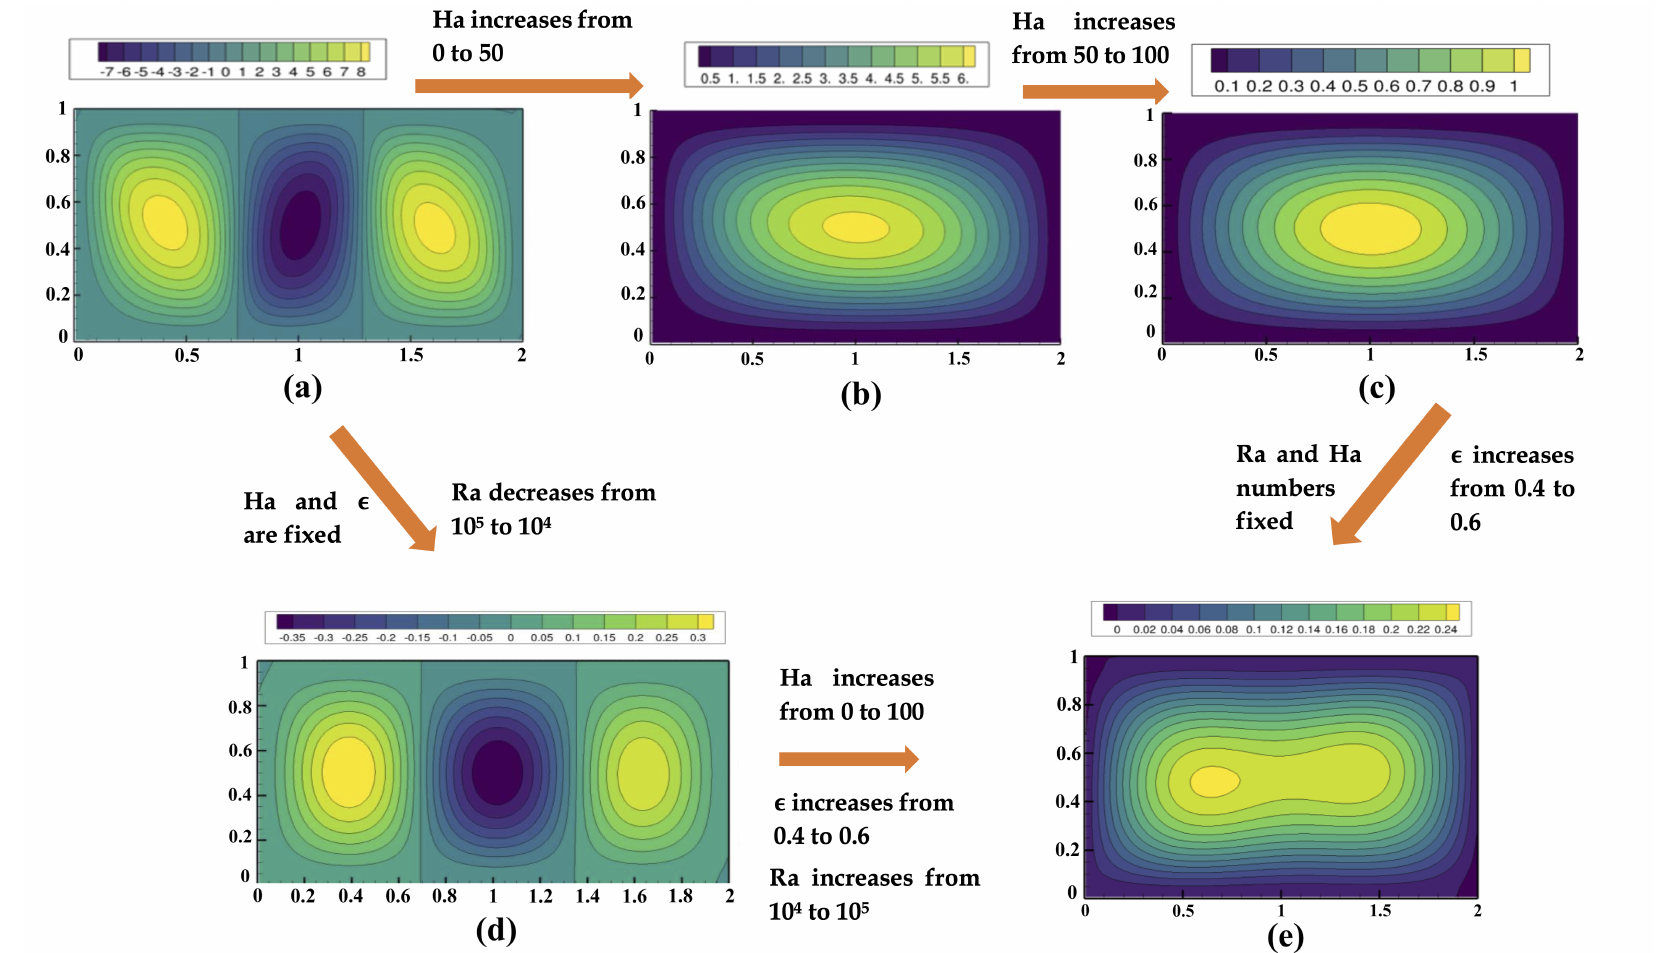
Figure 3. Illustrations of streamlines as Ra , Ha numbers, and (cid:101) varied under θ = 0, and Da = 10 − 2 : ( a ) Ra = 10 5 , (cid:101) = 0.4, and Ha = 0, ( b ) Ra = 10 5 , (cid:101) = 0.4, and Ha = 50, ( c ) Ra = 10 5 , (cid:101) = 0.4, and Ha = 100, ( d ) Ra = 10 4 , (cid:101) = 0.4, and Ha = 0, ( e ) Ra = 10 5 , (cid:101) = 0.6, and Ha =